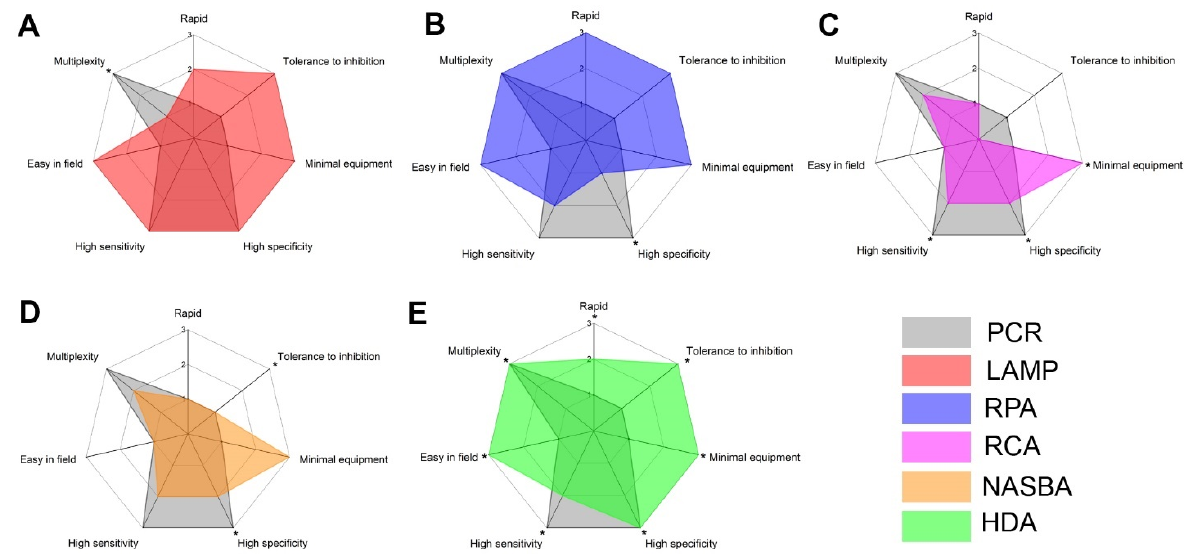
Figure 5. Multiparametric comparison of isothermal amplification methods for plant pathogen detection. PCR as “gold standard” of diagnostic is compared with: ( A ). loop-mediated amplification, ( B ). RPA, ( C ). rolling circle amplification, ( D ). nucleic acid sequence-based amplification, ( E ). helicase-dependent amplification. The parameters are ranged by analysis of publications. Numbers represent arbitrary pronouncing of the corresponding parameters based on corresponding PCR parameters: 0. No data, 1. Weak, 2. Intermediate, 3. High (see additional specifications in Supplementary Information, Section S2). Axes of parameters that were evaluated by non-plant data are marked by-*. Table 3. Comparison of visual detection methods of amplicons for plant pathogen detection.